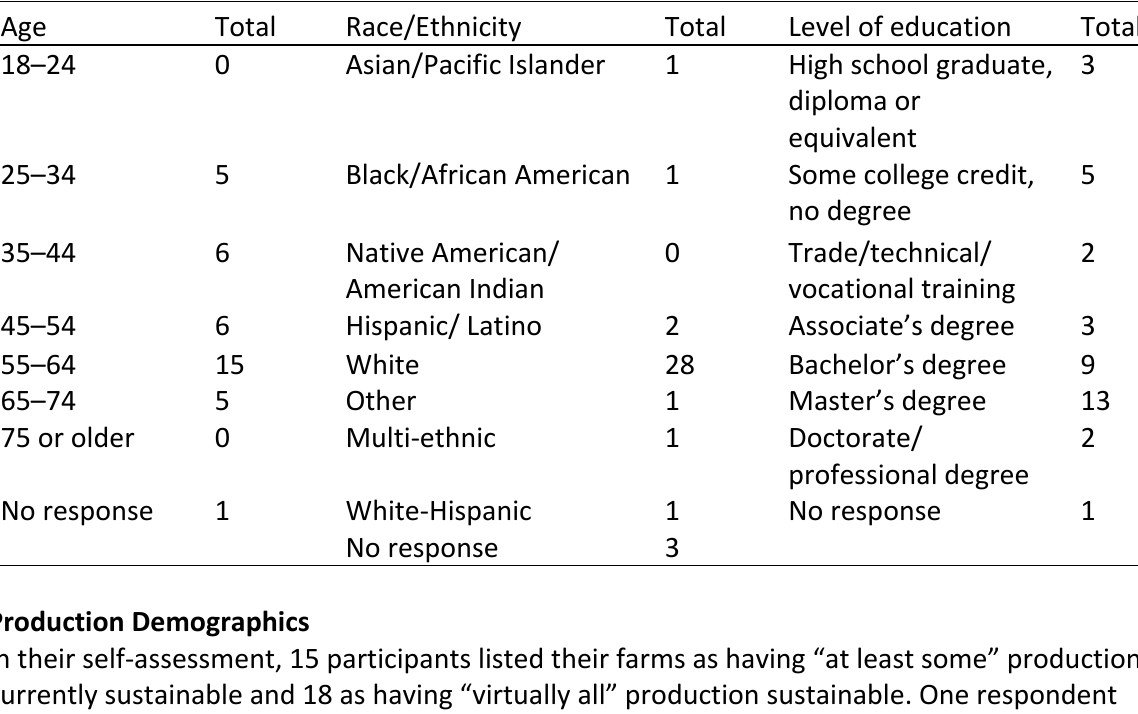
Table 1 Survey Respondent